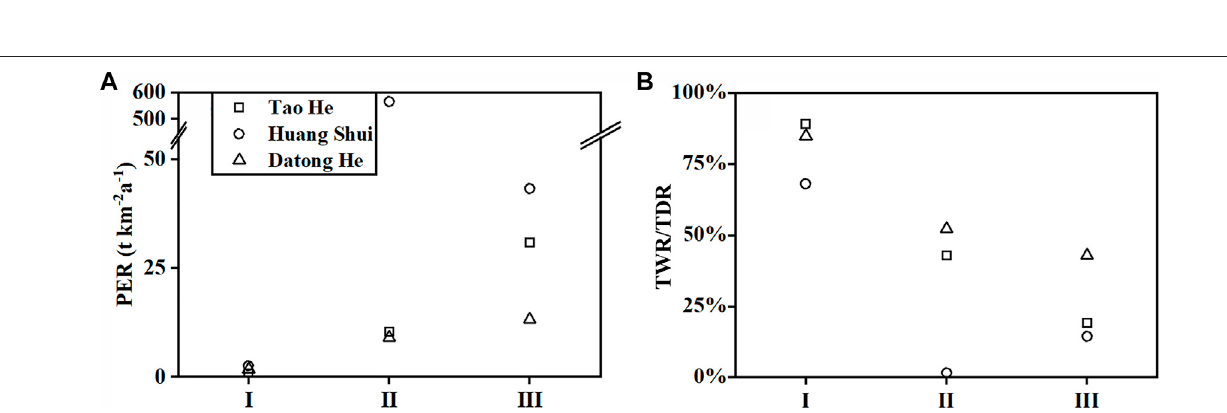
FIGURE 5 | Relationships between the CO 2 consumption rates of carbonate (black symbols) and silicate (blue symbols) weathering and (A) the relief ratio (relief/ basin length) and (B) runoff (water discharge/surface area) in the transition zones and the LP sections of the Tao He, Huang Shui, and Datong He in summer. The solid symbols represent the transition zone. The un fi lled symbols represent the LP section. In this paper, river length is substituted for basin length. Data for relief ratio and runoff are in Supplementary Table S4 .